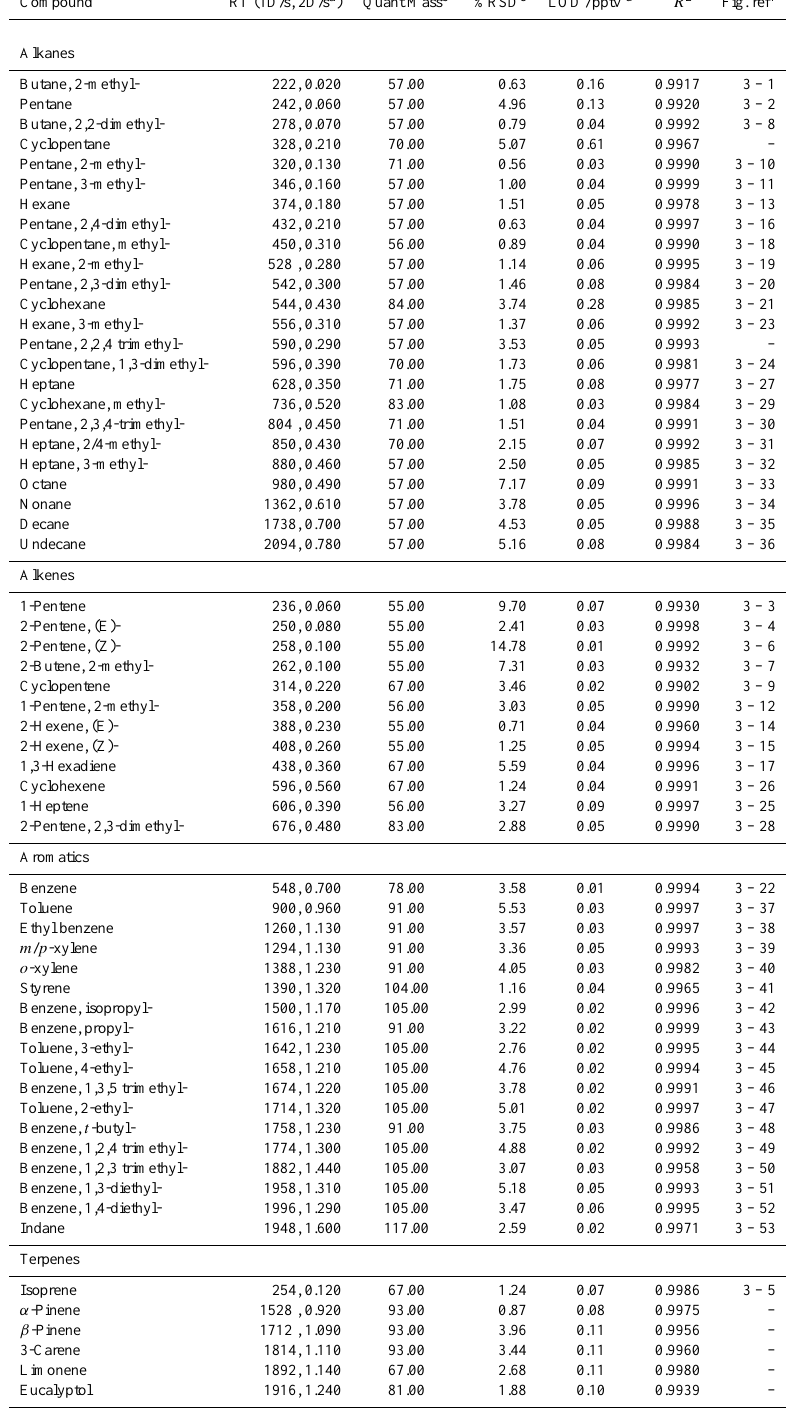
Table 1. List of quantifiable compounds and validation parameters for the AR74 hydrocarbon standard using GC × GC-TOFMS. Grouped by functionality and compounds given in retention